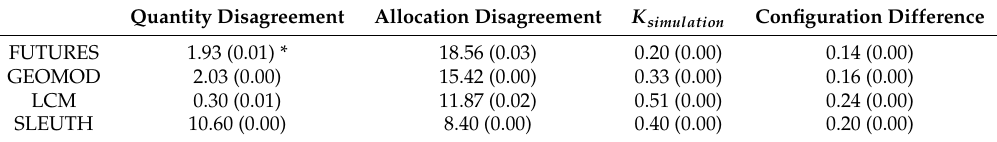
Figure 3. Average quantity and allocation disagreement ( n = 10) for each model. Quantity and allocation disagreement together equal the total disagreement of the model. Table 3. Summarized results for each measure of accuracy for each land change model. Average values across the ten simulations are provided with standard deviations in